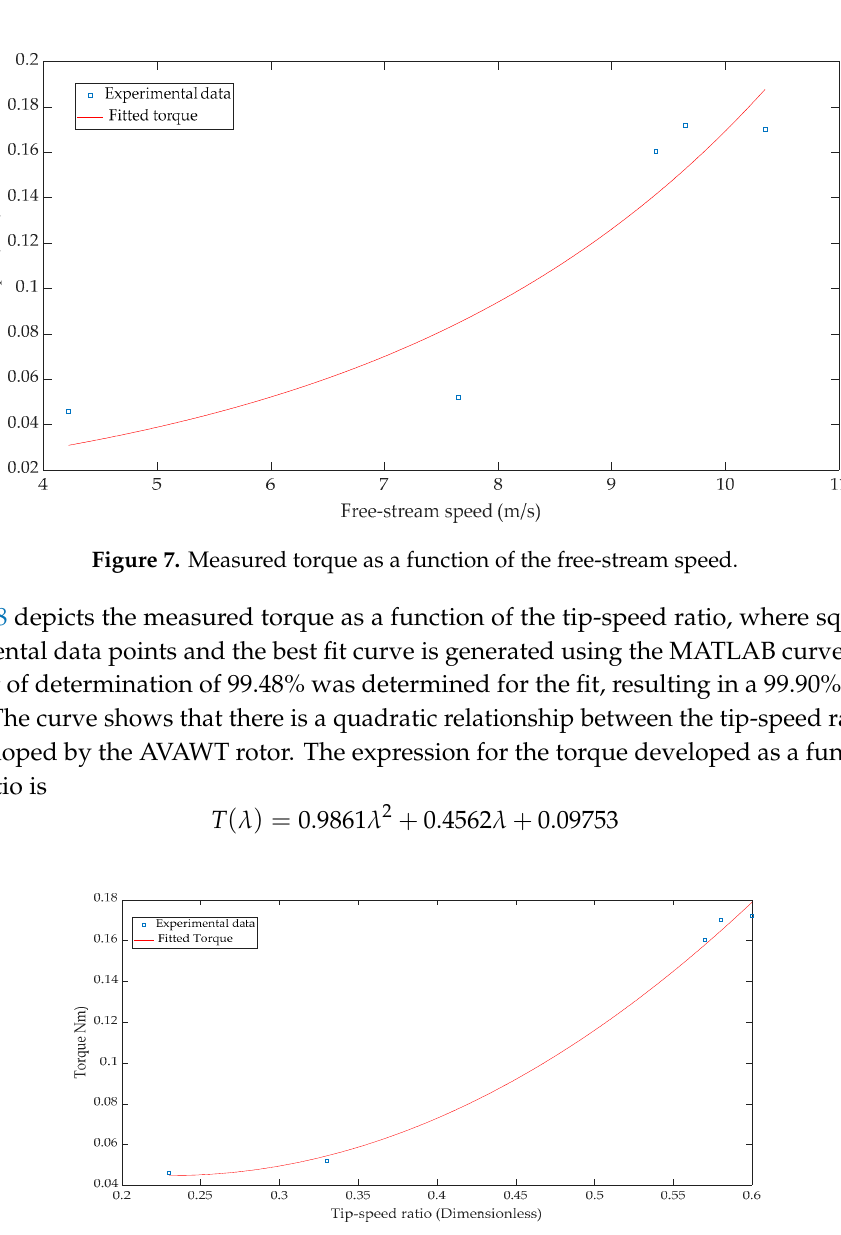
Figure 8. Measured torque as a function of the tip-speed ratio.